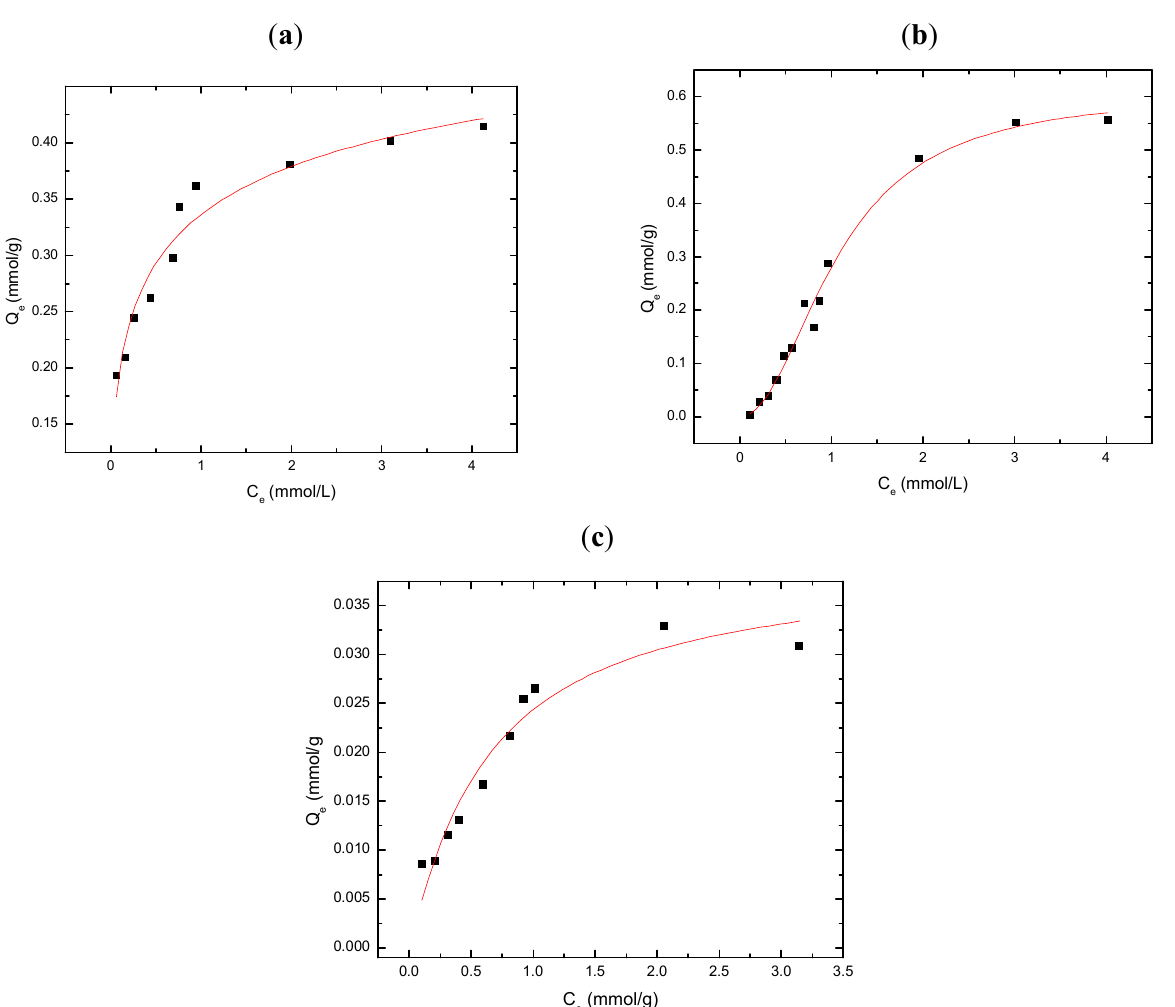
Figure 2. Sorption isotherms for 2,4-D with various sorbents at pH 9.0 and 295 K; ( a ) GAC, ( b ) MDI-3, and ( c ) CDI-3. The solid line represents the best-fit curve according to the Sips isotherm (Equation